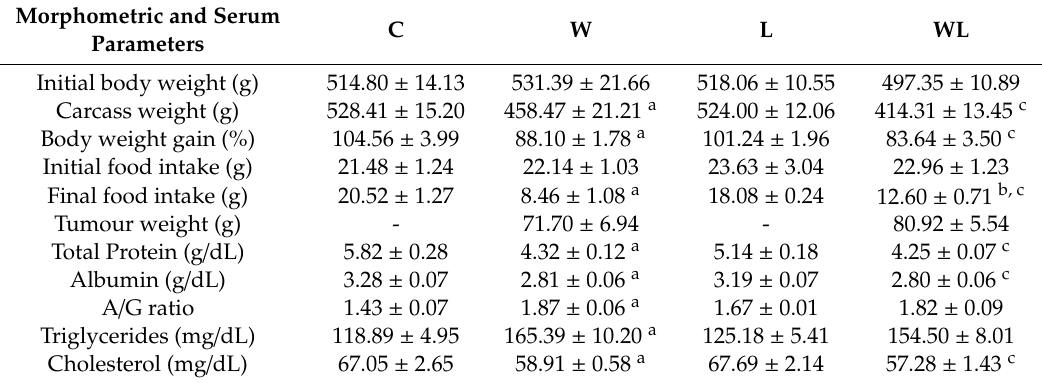
Table 2. Tumour growth a ff ected body weight, food intake, and serum parameters in the tumour-bearing groups.